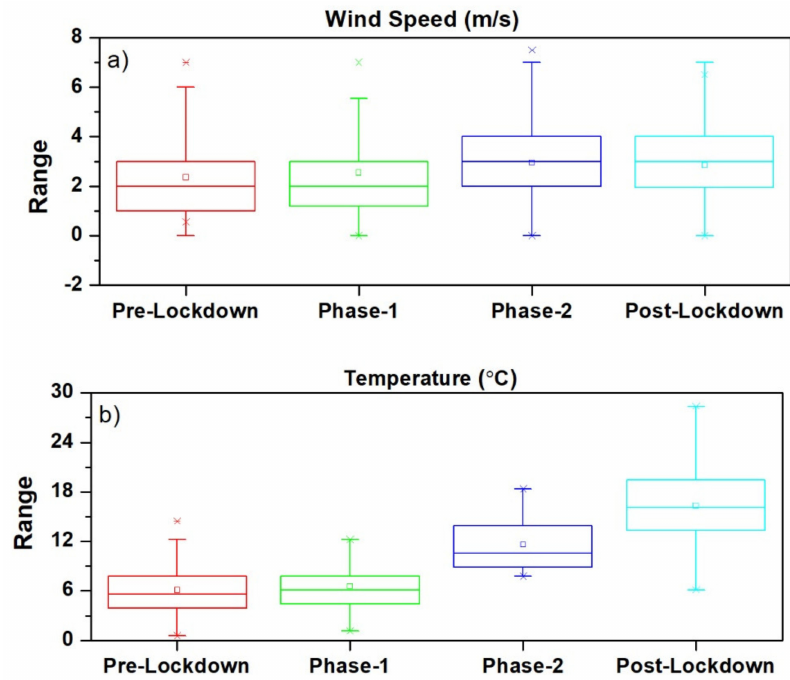
Figure 9. Boxplot for ( a ) wind speed(m / s) and ( b ) temperature ( ◦